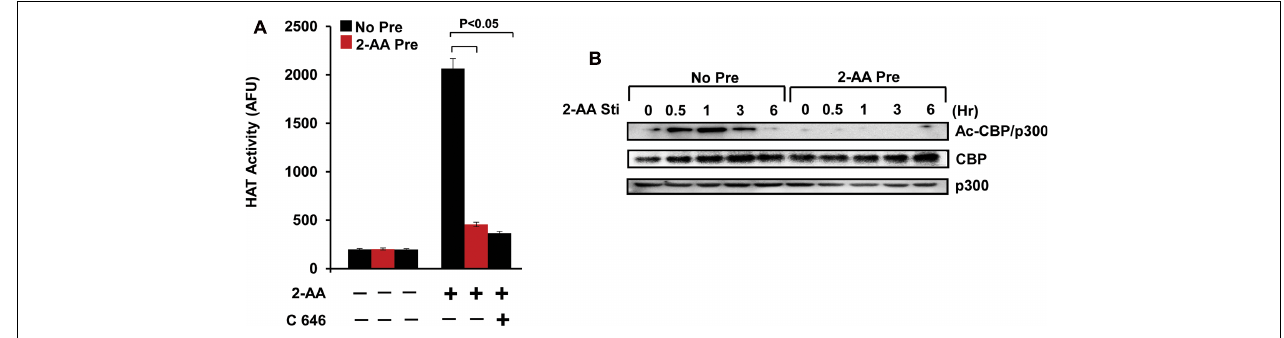
FIGURE 4 | 2-AA modulates CBP/p300-mediated HAT activity and the acetylation of CBP/p300. (A) HAT activity in nuclear lysate of 2-AA stimulated and 2-AA-tolerized THP-1 cells following 1 h 2-AA stimulation +/– of C646 ( n = 3; means ± SDs; p < 0.05, Student’s t -test). (B) Immunoblot showing decreased CBP/p300 acetylation in 2-AA-tolerized THP-1 cells. Data are representative of three independent experiments.